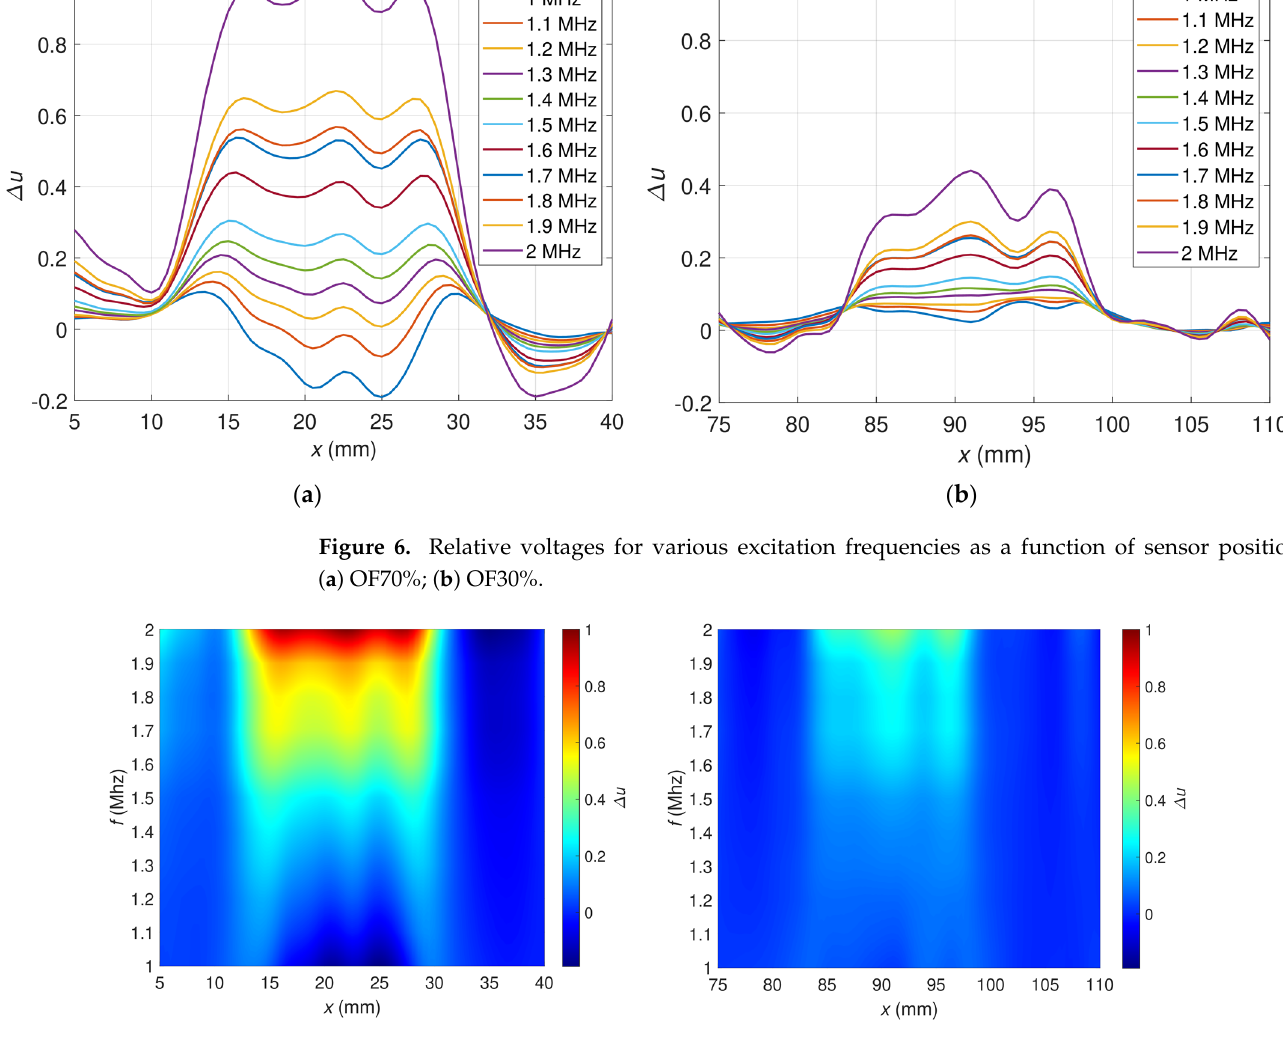
Figure 8. Maximum relative voltages as a function of the excitation frequency. The red line ap- proximates data for OF70%, while the blue line approximates data for OF30%. 3.4. Results of Two-Dimensional Examination with a Single-Frequency Excitation Figure 9 shows the relative voltage difference ∆(cid:1873) as a function of the transducer’s position along the x -axis and y -axis. The flaws OF70% (Figure 10a) and OF30% (Figure 10b) are detectable, but a high material anisotropy caused by the fiber alignment affects the results. Especially for minor hidden flaws, this makes it more difficult to detect and localize them. The undoubted advantage of the presented transducer, sensitivity to de- fects of different orientations in the case of anisotropic materials such as carbon fiber-re- inforced composites, generates interfering signals that make analysis more complicated.